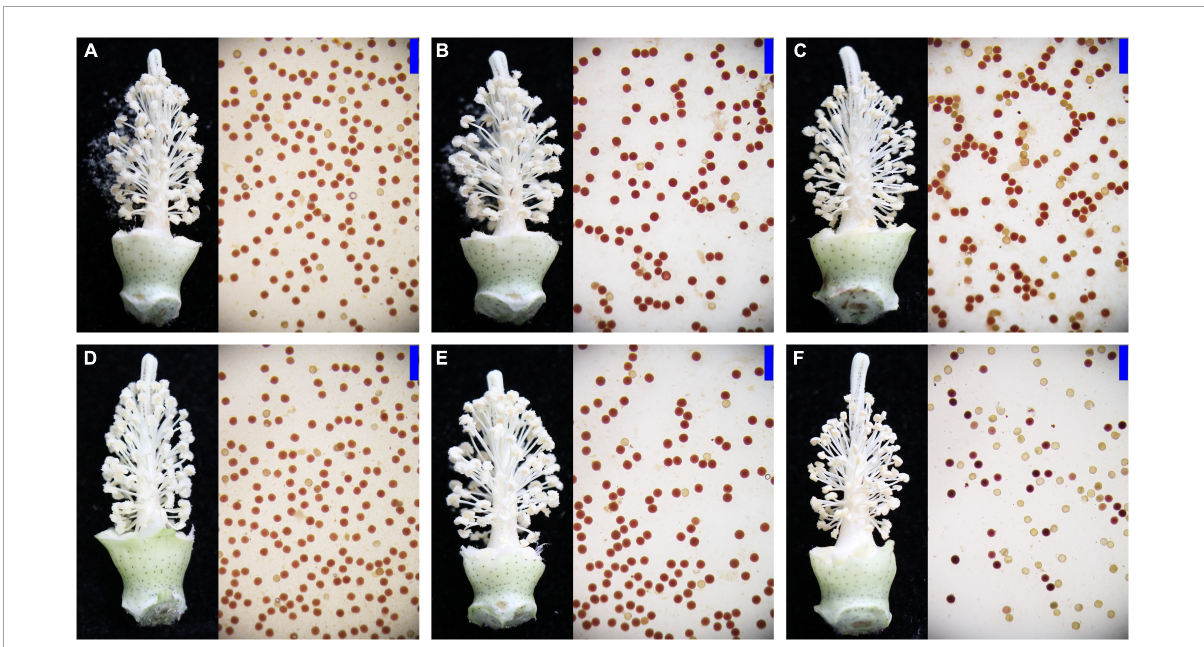
FIGURE1 Representative anther phenotypes of SH, NH, and NB in Anyang and Jiujiang. (A–C) Pollen from NB, NH, and SH in Anyang. (D–F) Pollen from NB, NH, and SH in Jiujiang. The fertile pollen grains were stained dark red and sterile pollen grains were stained bright yellow. Scale bars: 200 µ